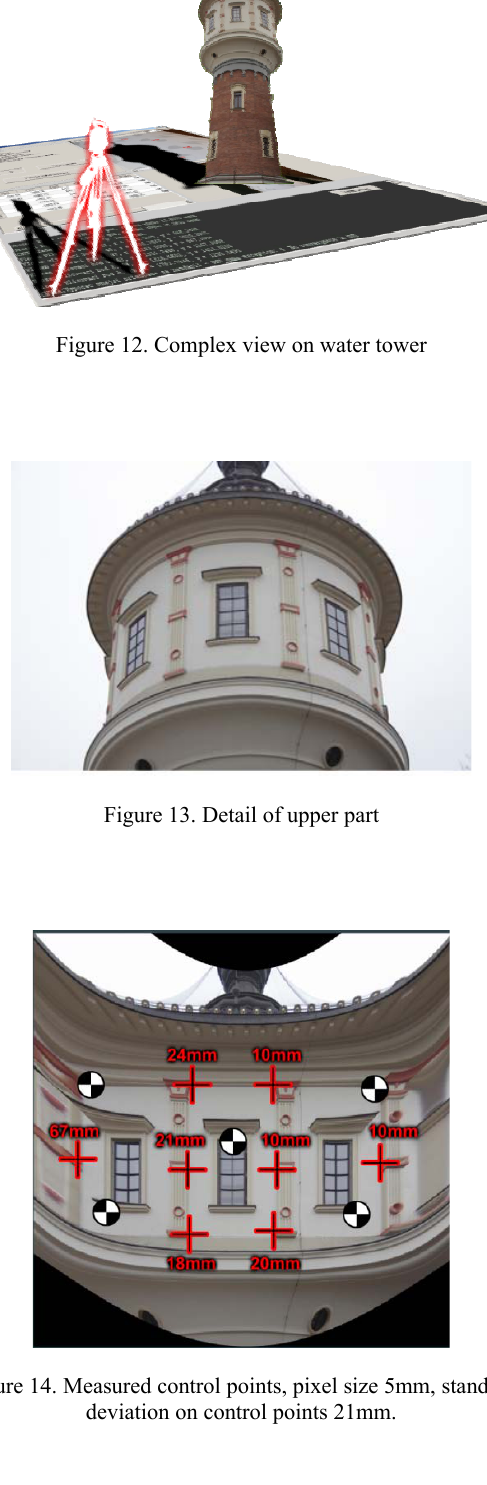
Figure 17. Unwrapping of the water tower lower